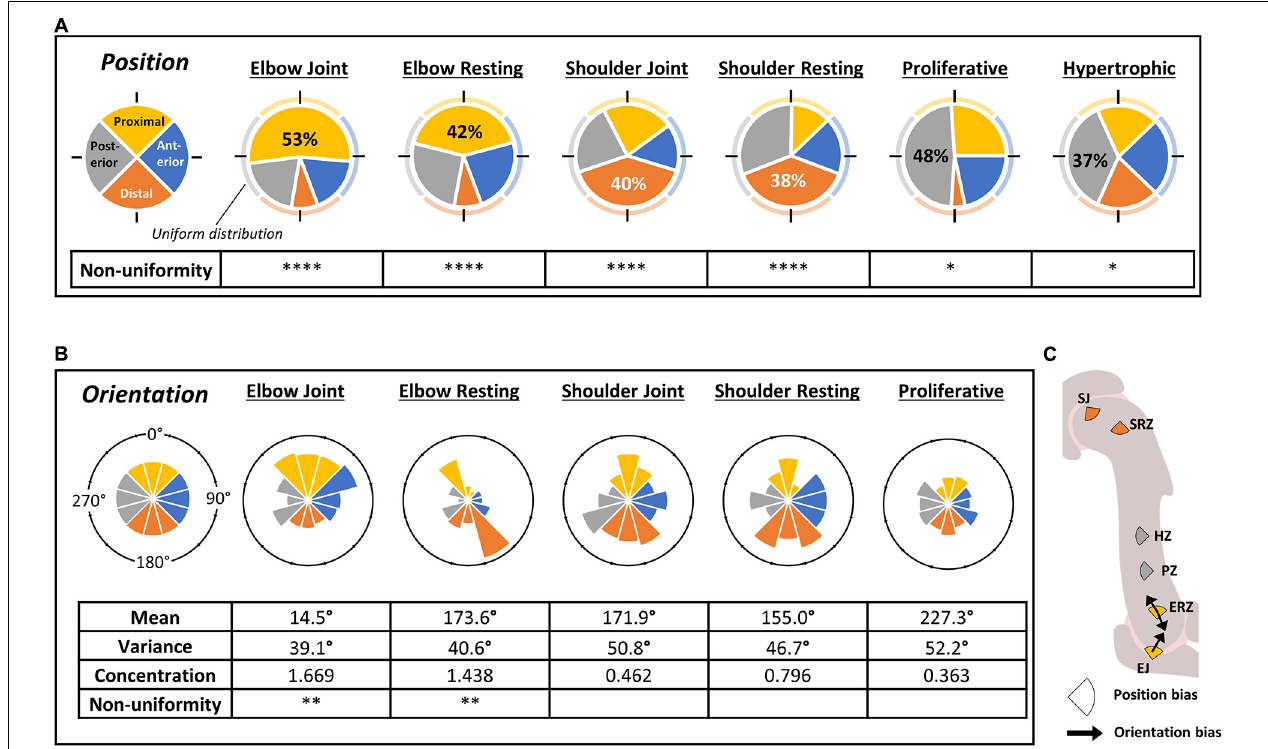
FIGURE 3 | The position of emergence and orientation of cilia on individual cells differs between regions of the normal developing humerus at TS23. (A) Pie charts of cilia emergence position on chondrocytes in different regions of the humerus, as indicated; each slice represents the proportion of cilia where the cilium base was located in the given quadrant (as illustrated in Figure 1B ); quadrants are color-coded as shown on extreme left where a uniform distribution of 25% in each quadrant is illustrated for comparison. All regions showed significant divergence from uniform distribution (chi-squared test) as indicated. Percentages are noted for the most enriched quadrant. (B) Rose histograms of cilium axoneme orientation on chondrocytes in different regions of the humerus, measured from the base to the midpoint of each cilium (as illustrated in Figure 1B (angle θ ); bin width = 30 ◦ ). Angular mean and variance, concentration, and non-uniformity were calculated using the CircStats package in R. High concentration values indicate concentration around certain orientations; low concentration values indicate uniformity. Non-uniformity significance refers to the difference of the observed data from a uniform distribution (Kuiper’s test of uniformity). (C) Schematic summary of data presented in (A,B) showing significant bias in cilium emergence position (oriented pie slices color coded as in A ) and axoneme orientation (arrows). Abbreviations as in Figure 2B ∗ p < 0.05, ∗∗ p < 0.01, ∗∗∗ p < 0.005, ∗∗∗∗ p < 0.001. N = 4 independent